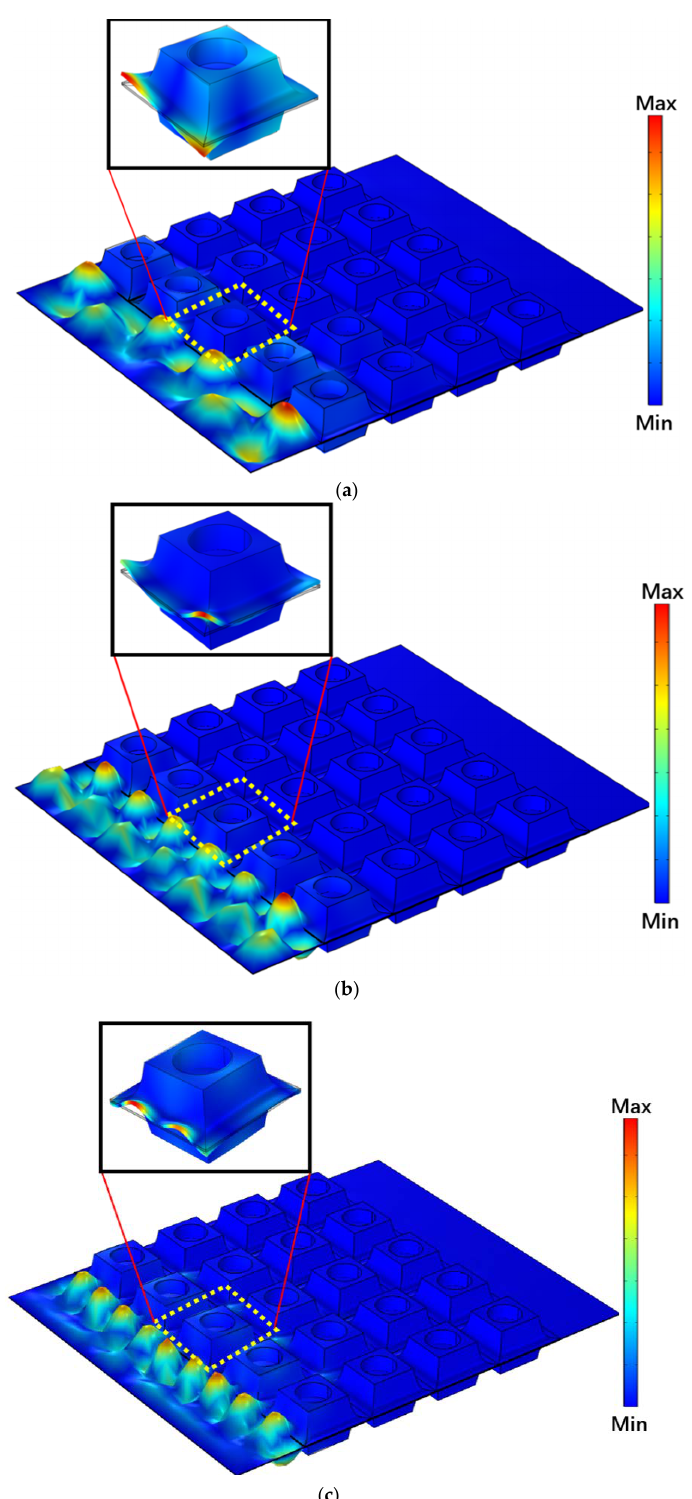
Figure 8. Distribution maps of the displacement field: ( a ) response to the excitation at 3913 Hz (Point A in the first band gap); ( b ) response to the excitation at 6880 Hz (Point B in the second band gap); ( c ) response to the excitation at 10,066 Hz (Point C in the third band gap).